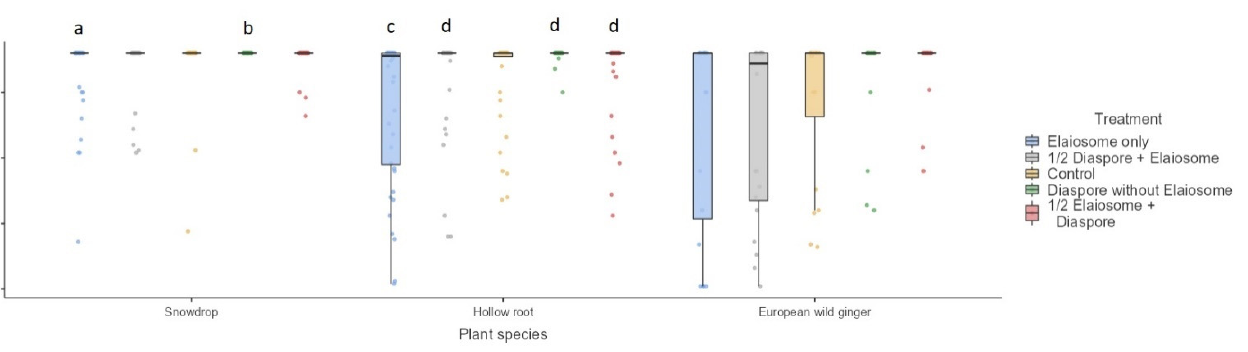
Figure 4. Mean first diaspore/elaiosome removal time (min) among three plant species. Box plots represent medians, 25th and 75th percentiles, minimum and maximum values. The letters above the bars denote significant differences according to pair-wise comparisons (a vs. b, p < 0.01, c vs. d, p < 0.05).